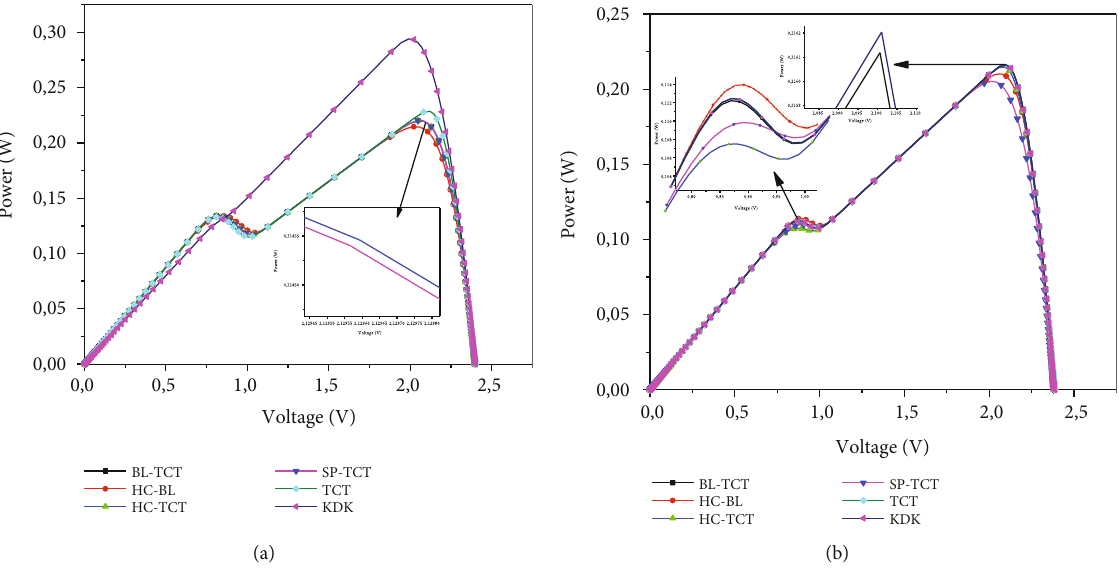
Figure 13: P-V characteristics of various PV module topologies operating in (a) CS-pattern and (b)